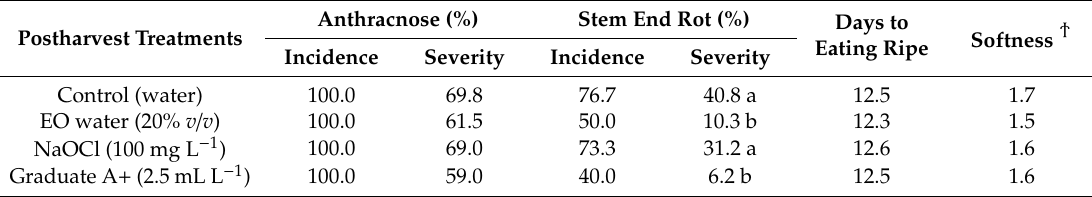
Table 5. E ff ect of electrolyzed oxidizing (EO) water and synthetic fungicides on postharvest diseases and ripening properties of avocado cv. Hass, Trial